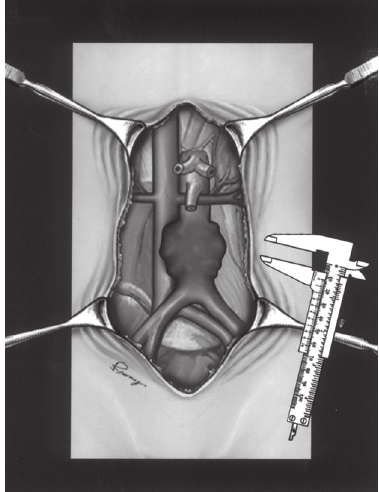
Figure 2 - The technique of aneurysm using a measurement